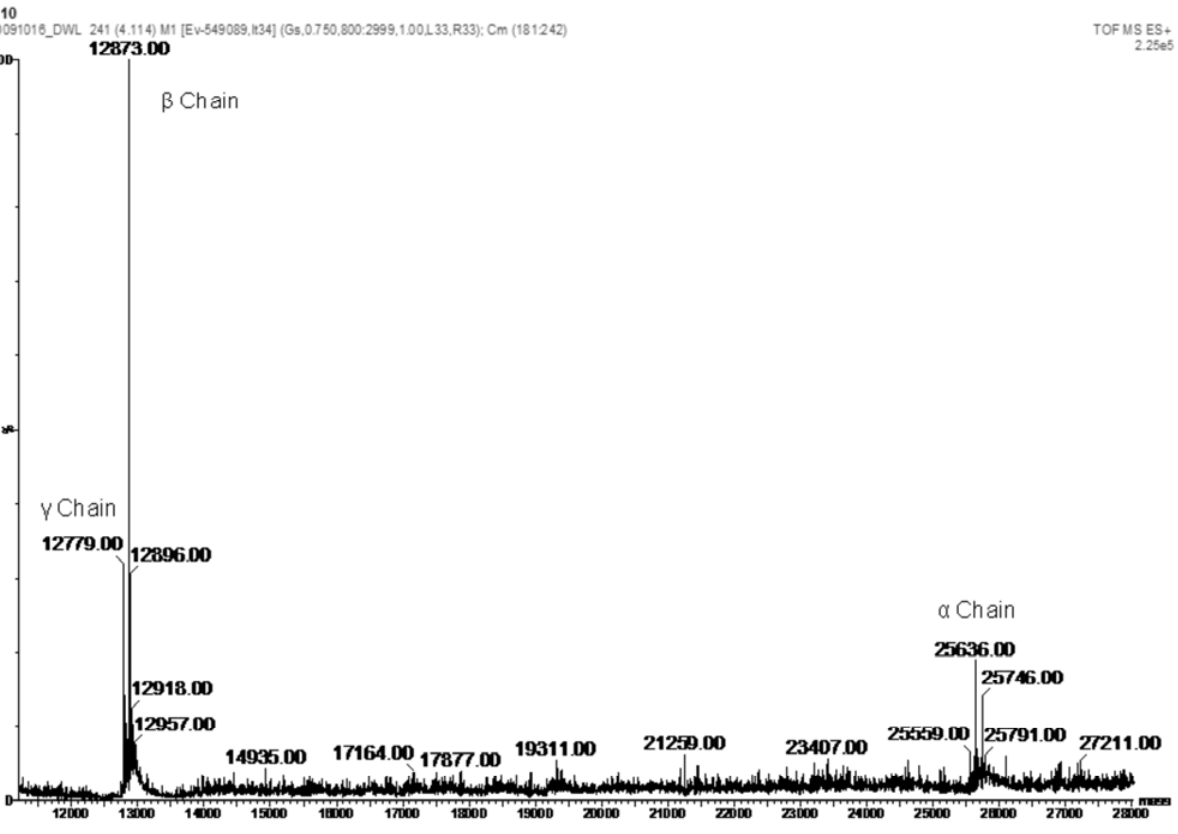
Figure 3. Deconvoluted mass spectra of lectin from the seeds of Dioclea wilsonii (DwL) acquired by ESI ionization in a hybrid quadrupole/ion mobility separator/orthogonal acceleration time-of-flight mass spectrometer.